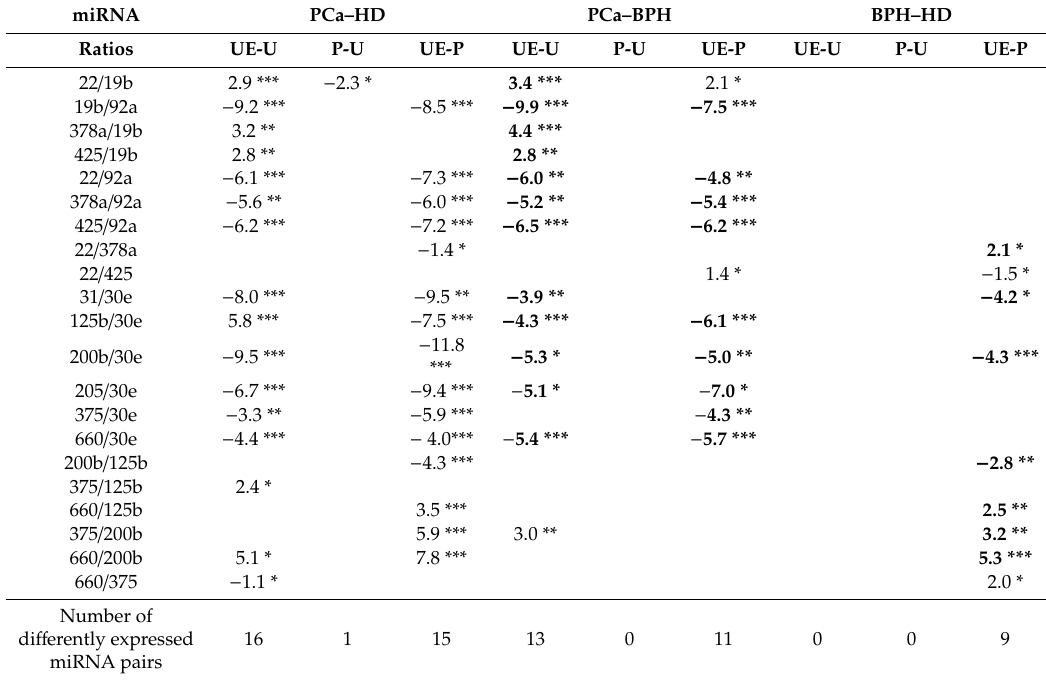
Table 2. The dddCt values for di ff erentially expressed miRNA pairs in the following groups of comparison: PCa–HD, PCa–BPH, BPH–HD.